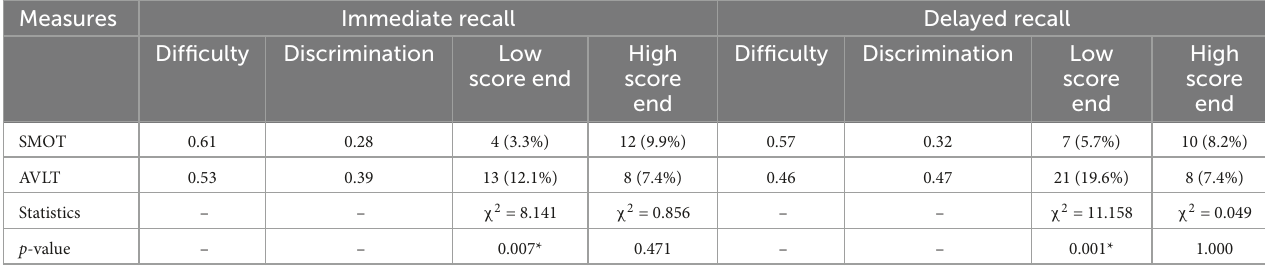
TABLE 4 Difficulties, discrimination, and scoring rates between the SMOT and AVLT. Measures